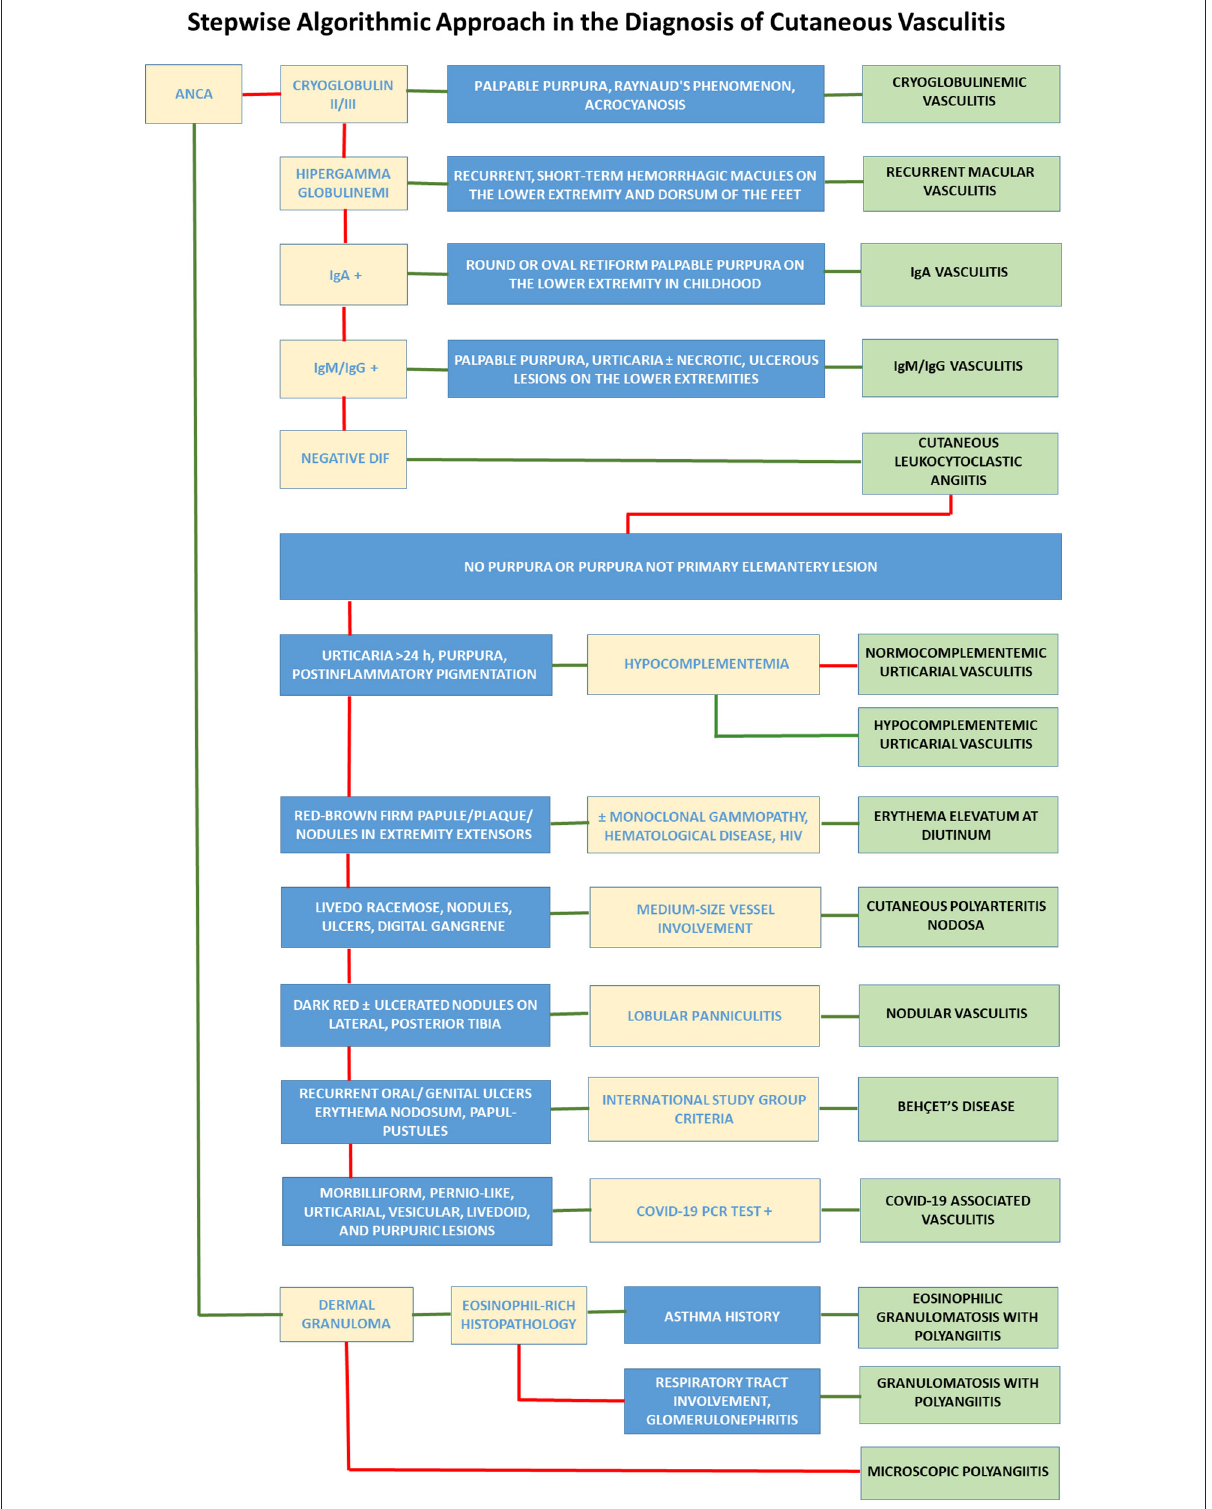
FIGURE1 Stepwise, algorithmic diagnosis of vasculitis. In the flowchart, all disease diagnoses are placed one under the other in the far right column. Algorithms start from the boxes in the upper left corner. The green arrow means “yes”, and the red arrow means “no”. ANCA, antineutrophilic cytoplasmic antibody; Ig, Immunoglobulin; DIF, direct